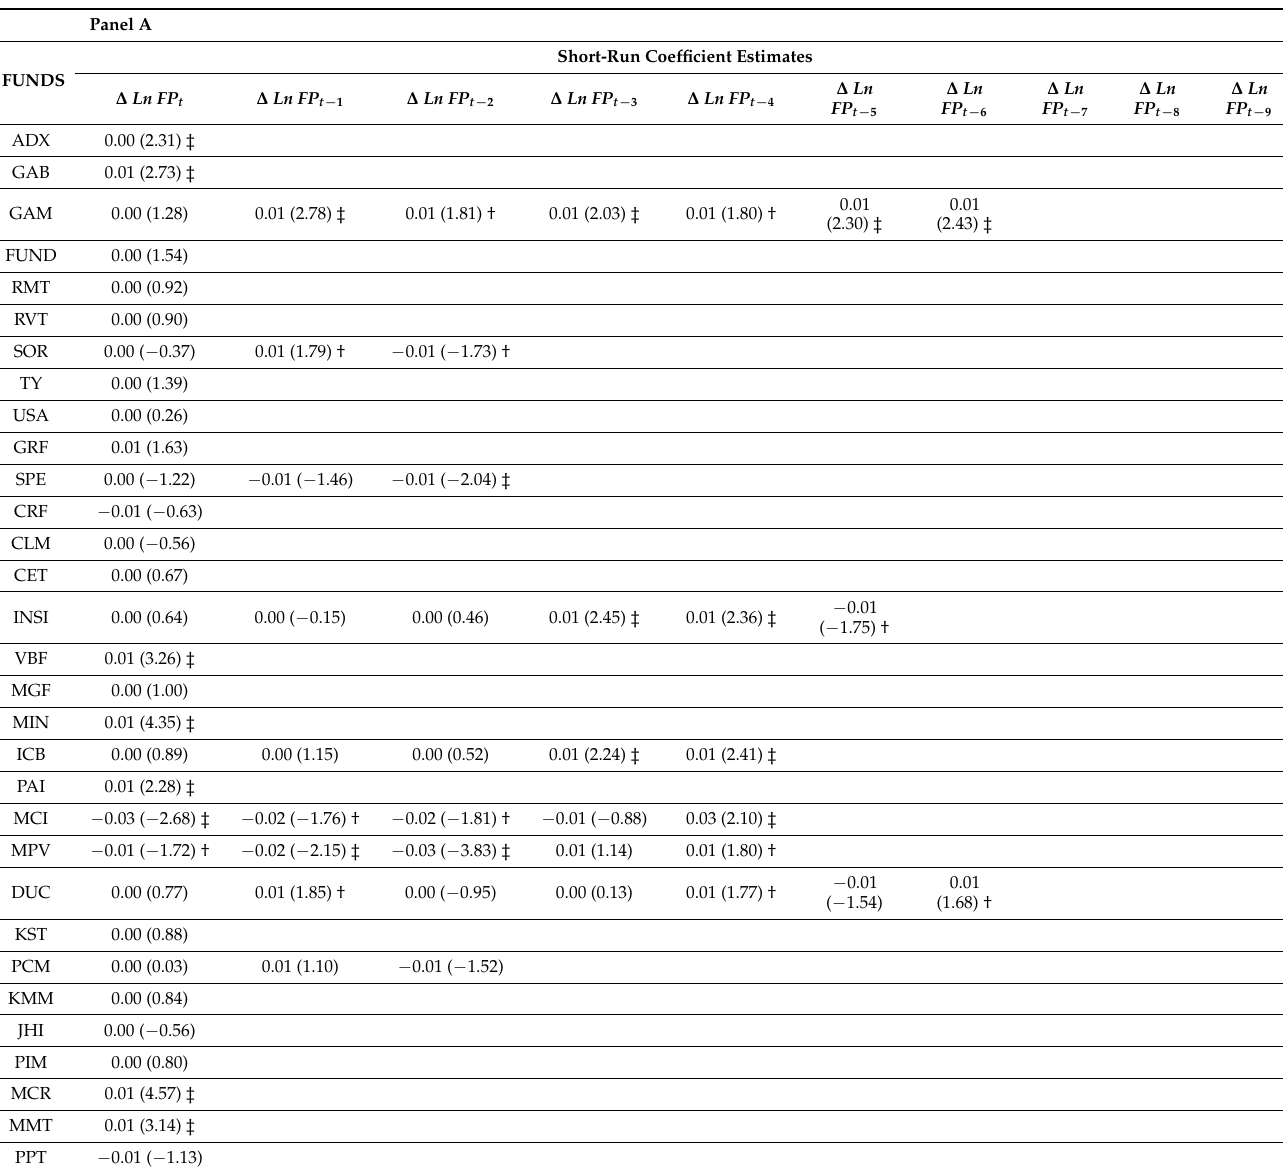
Table 3. Short-Run Coefficient Estimates—Linear ARDL—Model P = f (NAV,